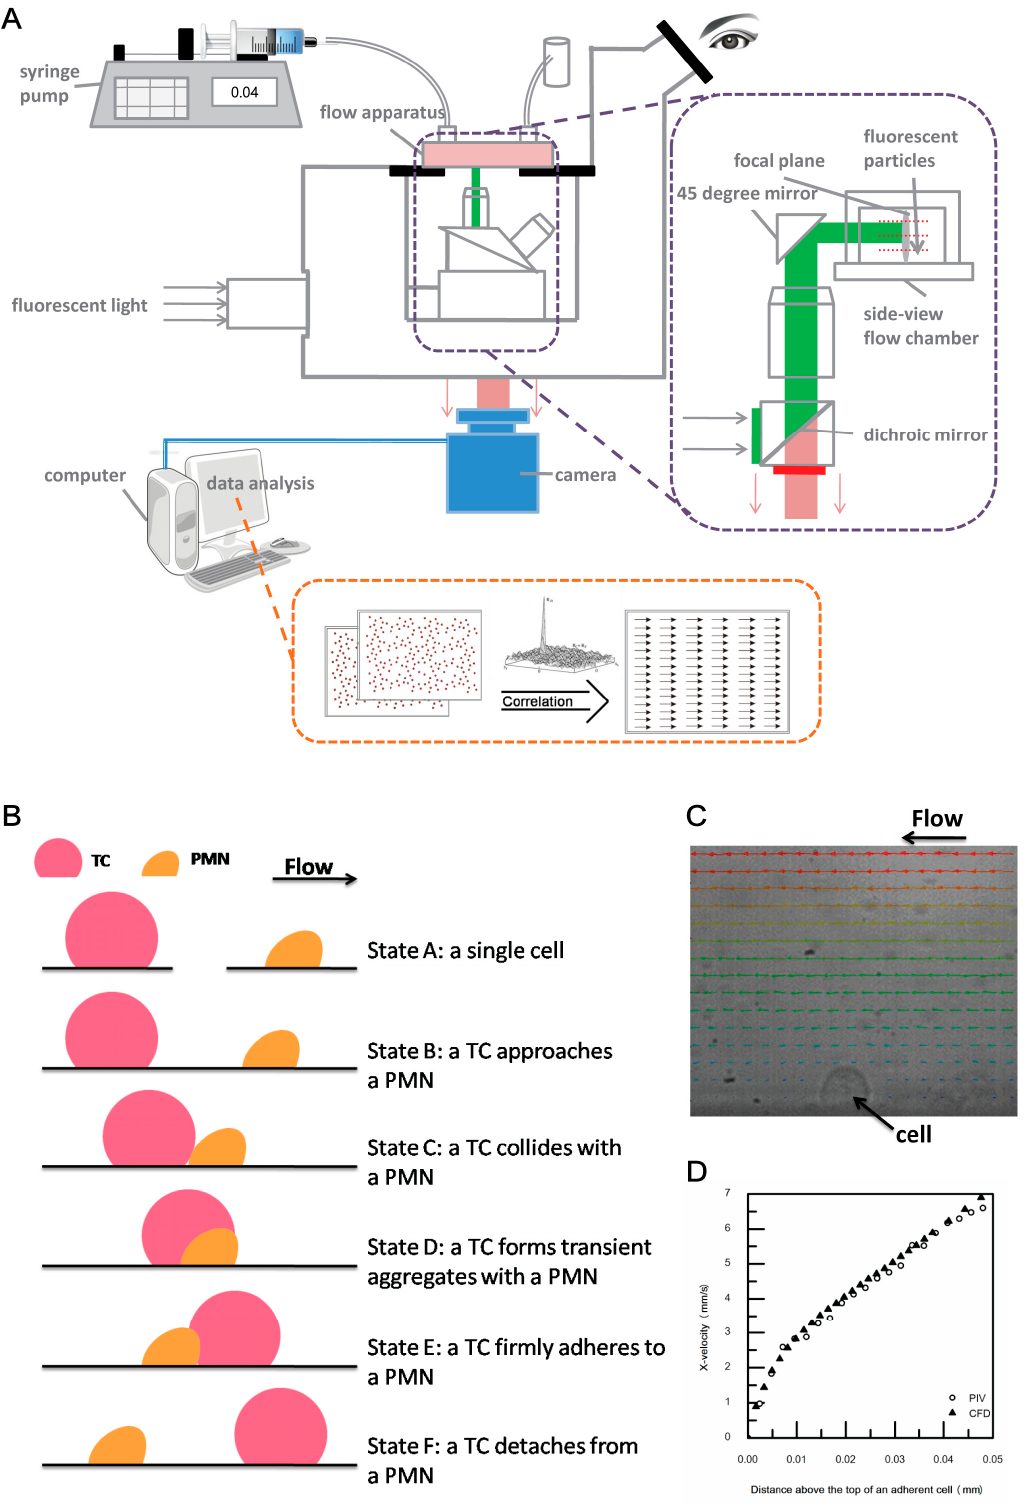
Figure 1. Illustration of side-view micro-PIV experiment and CFD simulation. ( A ) Setup of side-view micro-PIV system (drawn by the authors); ( B ) Six relative PMN-to-TC position states (PMN: polymorphonuclear neutrophil; TC: tumor cell); ( C ) Velocity profiles around an adherent cell; ( D ) Plot of a column of velocity profile above an adherent cell calculated from micro-PIV and CFD.